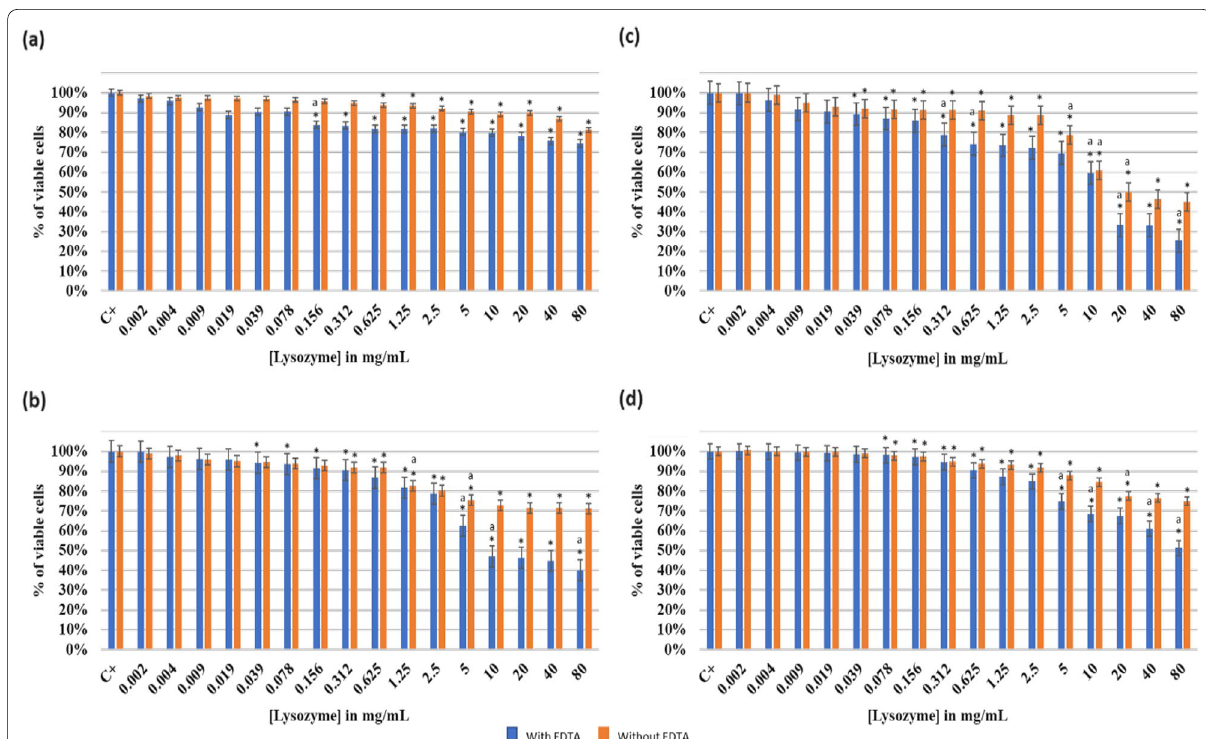
Fig. 2 Effect of lysozyme with and without EDTA (1 mM) on Staphylococcus epidermidis 444 at different pH: a pH 2; b pH 6; c pH 7.5 and d pH 8.5. The results are mean values of three replicates. OD 600 of the positive controls: C + (a) a significant difference (P < 0.05) between each test and the positive control (without lysozyme). The lowercase letter a indicates a significant difference (P < 0.05) between each test and its preceding. Error bars represent the SD (standard